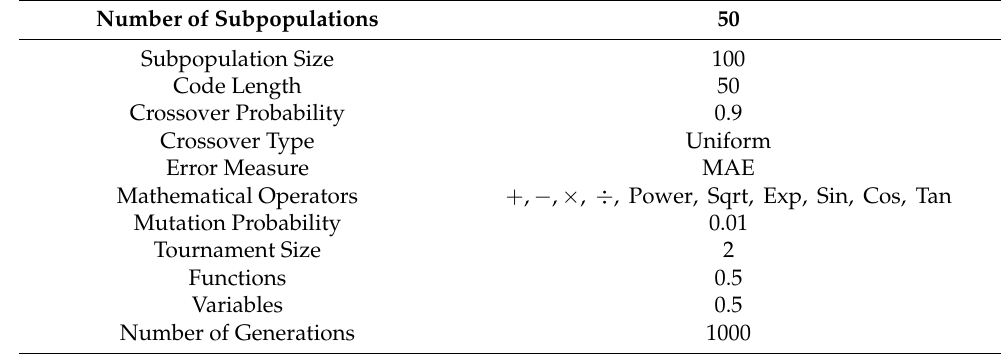
Table 5. Parameters settings for MEP